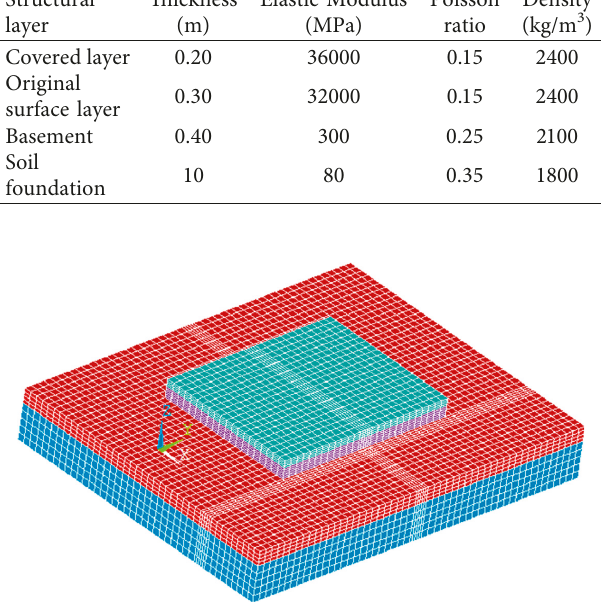
Figure 11: ACCDDPS